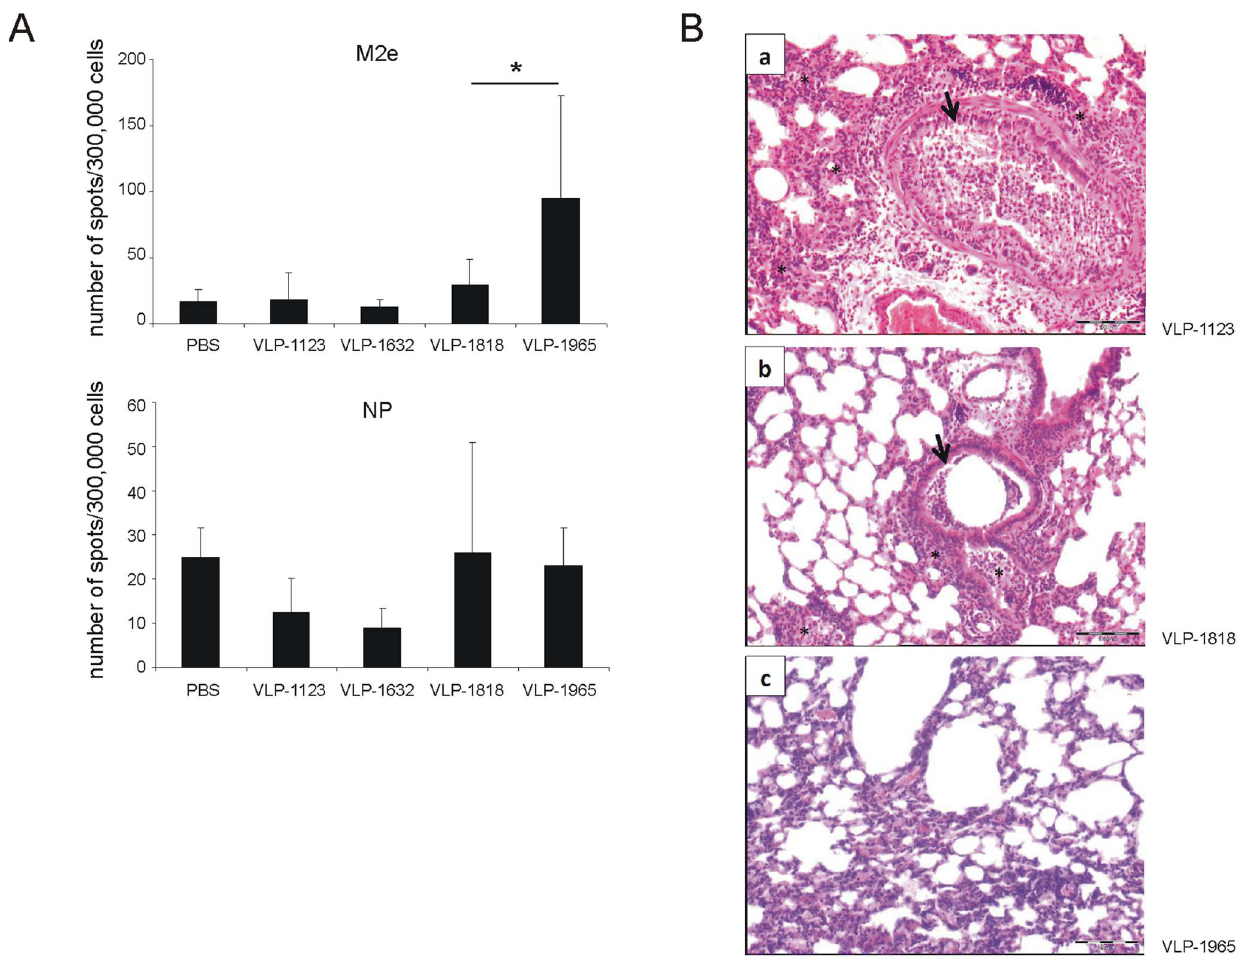
Figure 7. Cellular immune responses and histopathology following challenge. Mice were immunized as described in the legend of Figure 6. A. Six days after challenging the mice with 4 LD 50 of X47 virus, four (PBS) or five (all other groups) mice from each group were sacrificed to prepare splenocytes. IFN- c responses after M2e (top) or NP (bottom) peptide restimulation were determined by ELISPOT analysis. Bars represent the average number of spots determined for individual mice (analyzed in triplicate) from each group. Error bars represent standard error of the mean. (*: P , 0.05). B. Representative hematoxylin-eosin stained lung tissue section prepared on day four after challenge of mice immunized with 10 m g of Alhydrogel- adjuvanted VLP-1632, VLP-1818 or VLP-1965. VLP-1123 (a): diffuse presence of a pronounced interstitial, alveolar (*) and bronchiolar (arrow) mixed inflammatory infiltrate interlaced with necrotic debris. VLP-1818 (b): focal presence of a limited mixed inflammatory infiltrate both in the interstitial, alveolar (*) as well as bronchiolar (arrow) structures. VLP-1965 (c): Some congestion, but no inflammatory reaction.